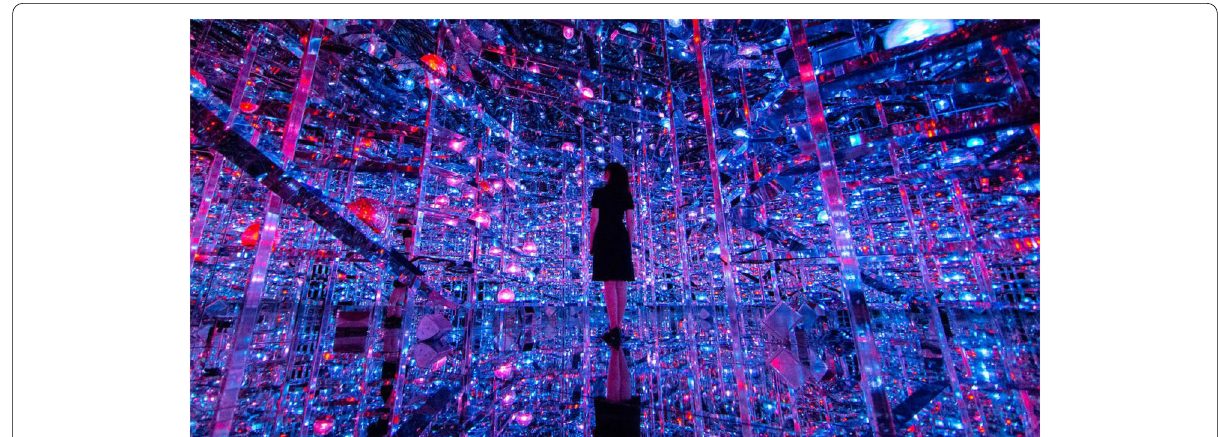
Fig. 38 The artwork created by teamLab. They combine multiple art types into one artwork to create a body immersive experience for users